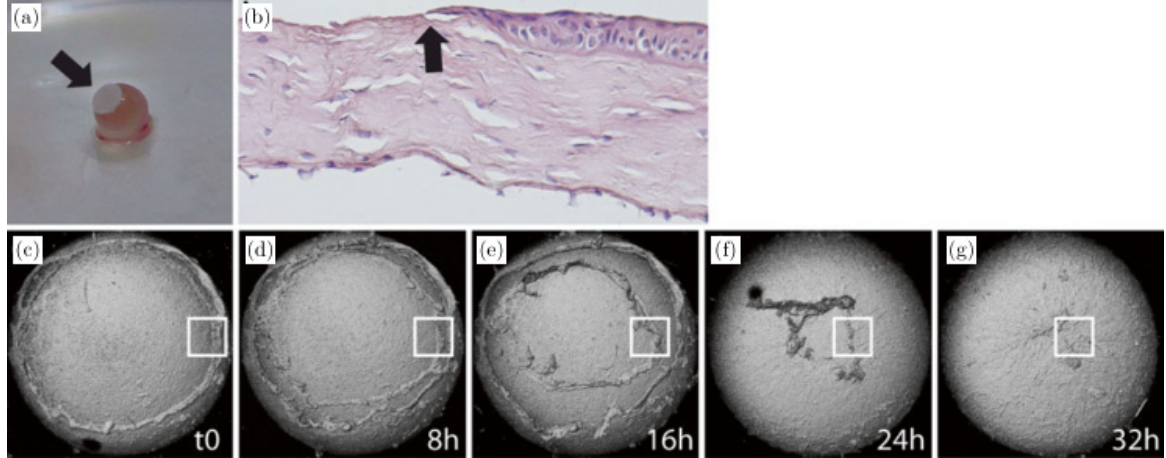
Fig. 9. Explanted murine eye model. (a) Explanted eye with a NaOH-containing ¯lter paper (arrow) placed on the cornea. (b) Section through the edge of the erosion. At the leading edge, epithelial cells are elongated (arrow) and stretched towards the central cornea. (c) – (g). OCT imaging of the cornea demonstrates the time course of epithelial wound healing. 40 (Permission has been granted by \Springer" through Copyright Clearance Center's RightsLink r